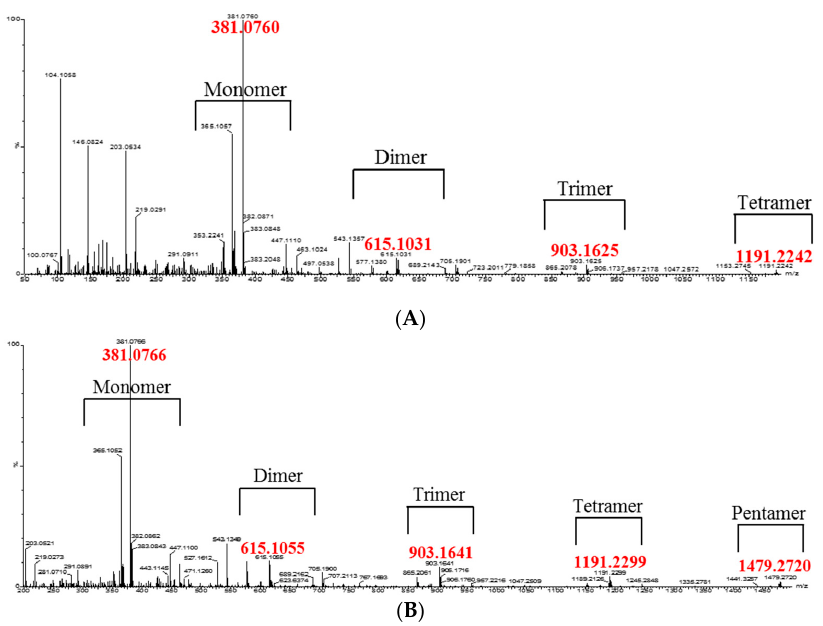
Figure 4. The synthesis of oligomeric anthocyanins from another monomeric anthocyanin (proanthocyanidin) using crude enzyme derived from Aspergillus niger . ( A ) Before biosynthesis; ( B ) after biosynthesis.